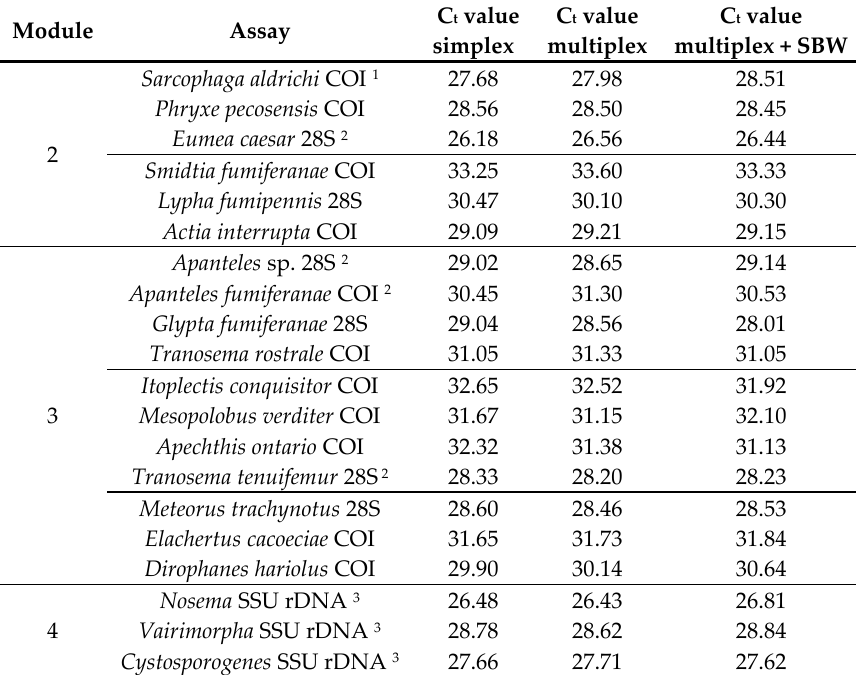
Table 5. Validation assays for Modules 2 to 4 of the molecular sorting tool, using purified DNA or crude lysates, tested in simplex and multiplex formats, as well as in multiplex format spiked with spruce budworm (SBW) DNA (10 fg). Prior to conducting these tests, ca. 100 copies of the 28S rDNA gene were processed through Module 1; the same quantity of DNA was used for processing in the other three